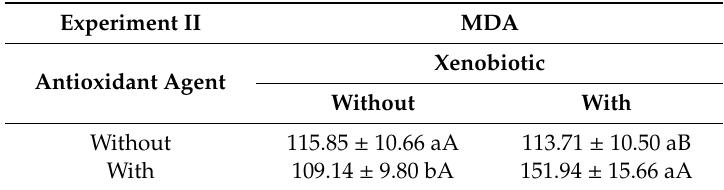
Table 10. Malondialdehyde content (mmol mg protein − 1 ) in soybean plants submitted to different soil water potentials and xenobiotic and antioxidant agent applications.